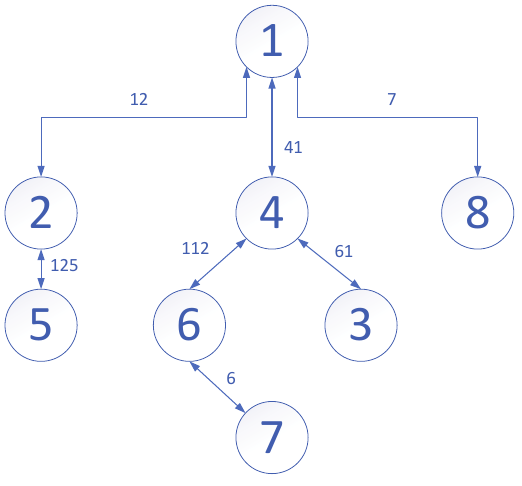
Figure 2. Structures of sub-networks in Figure